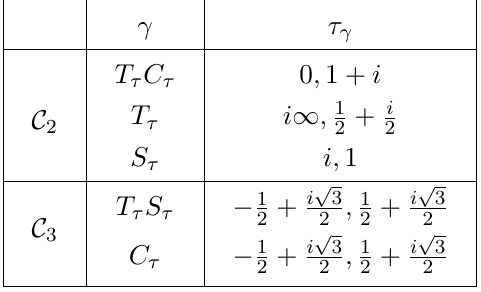
Table 1 . The non-identity elements of Γ 2 and respective